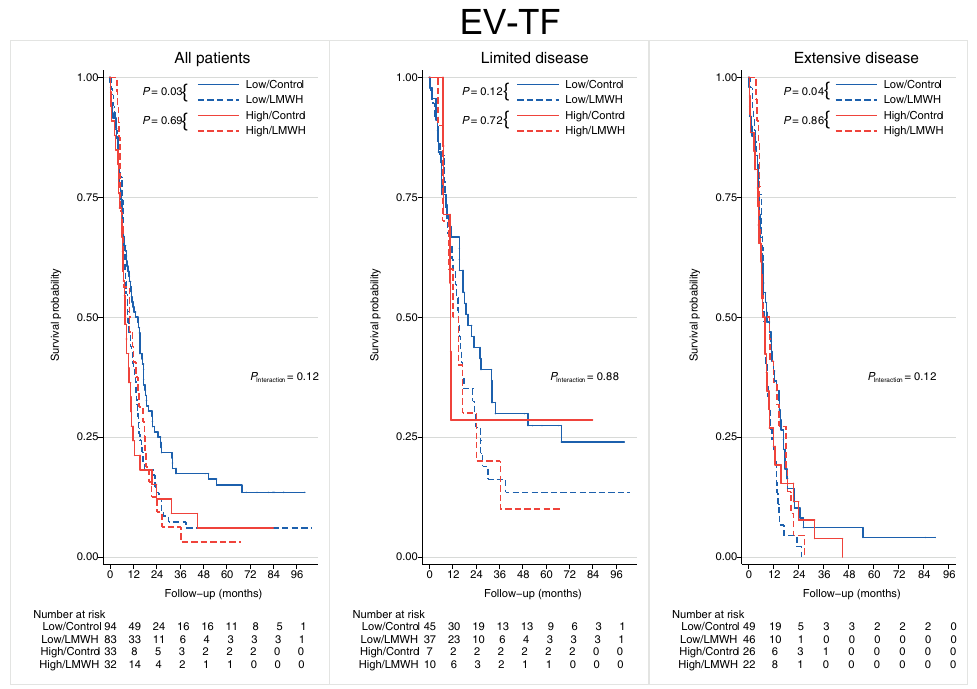
Fig 4. Kaplan-Meier curve of the predictive values of baseline EV-TF (cut-off at the 75th percentile) on the effect of LMWH on overall survival, for all patients and by disease